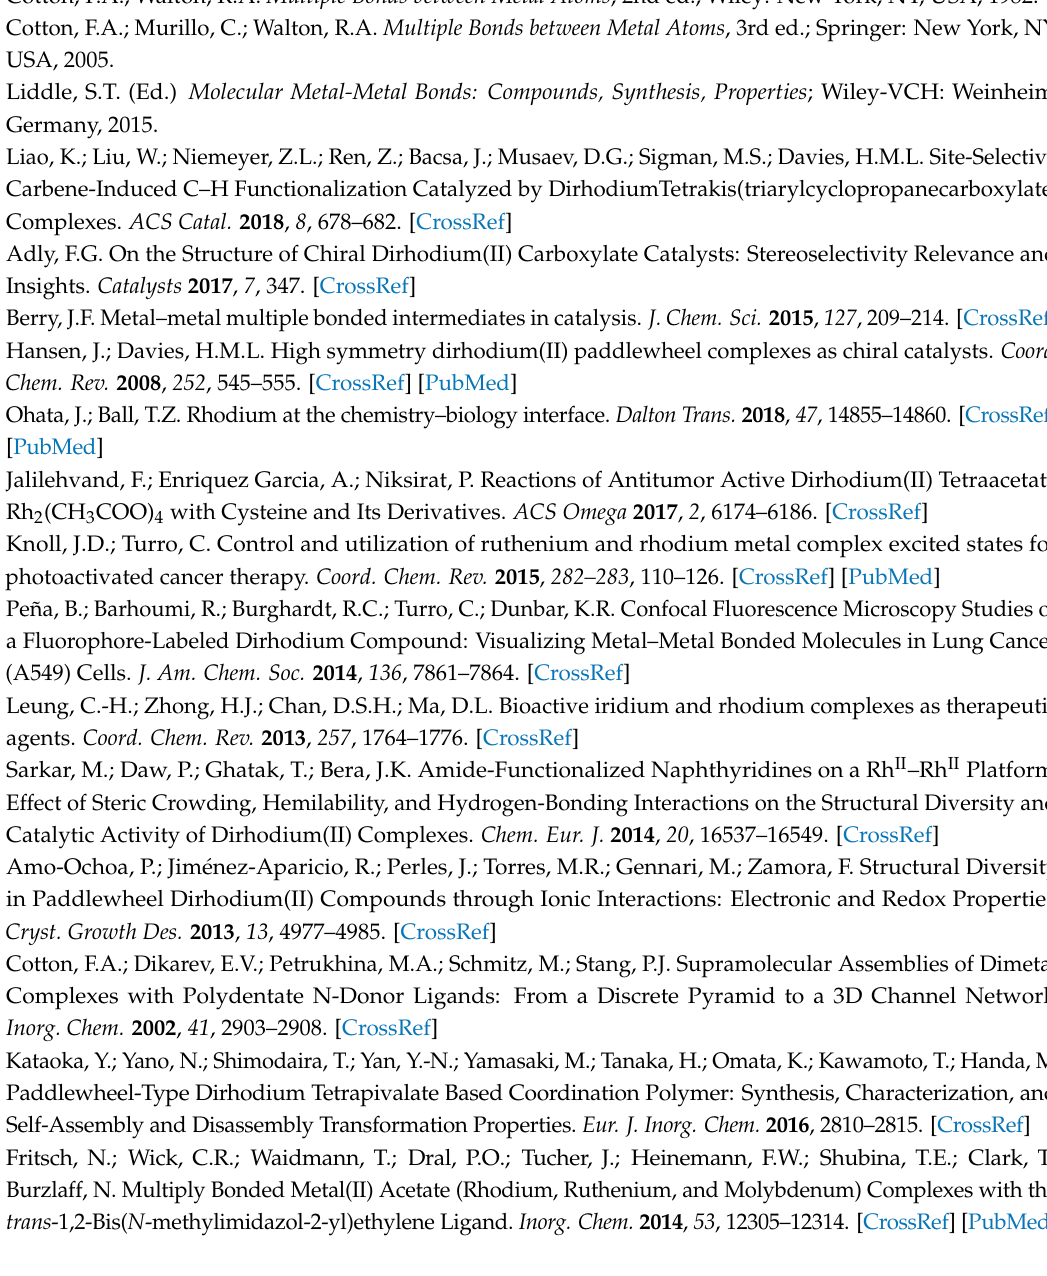
axis: Figure S8: Representation of the structure of 5 along the a axis. Figure S9: Interactions found between the closest (PPh 4 ) + cations in the structure of 3a . Figure S10: Interactions found between the closest (PPh 4 ) + cations in the structure of 3b . Figure S11: Closest (PPh 4 ) + cations in the structure of 4 . Figure S12: Interactions found between the closest (PPh 4 ) + cations in the structure of 5 . Figure S13: Representation of the structure of 6 along the c axis and view of the interactions between the closest (PPh 4 ) + cations. Figure S14: Interactions found between the closest cations and anionic chains in the structure of 4